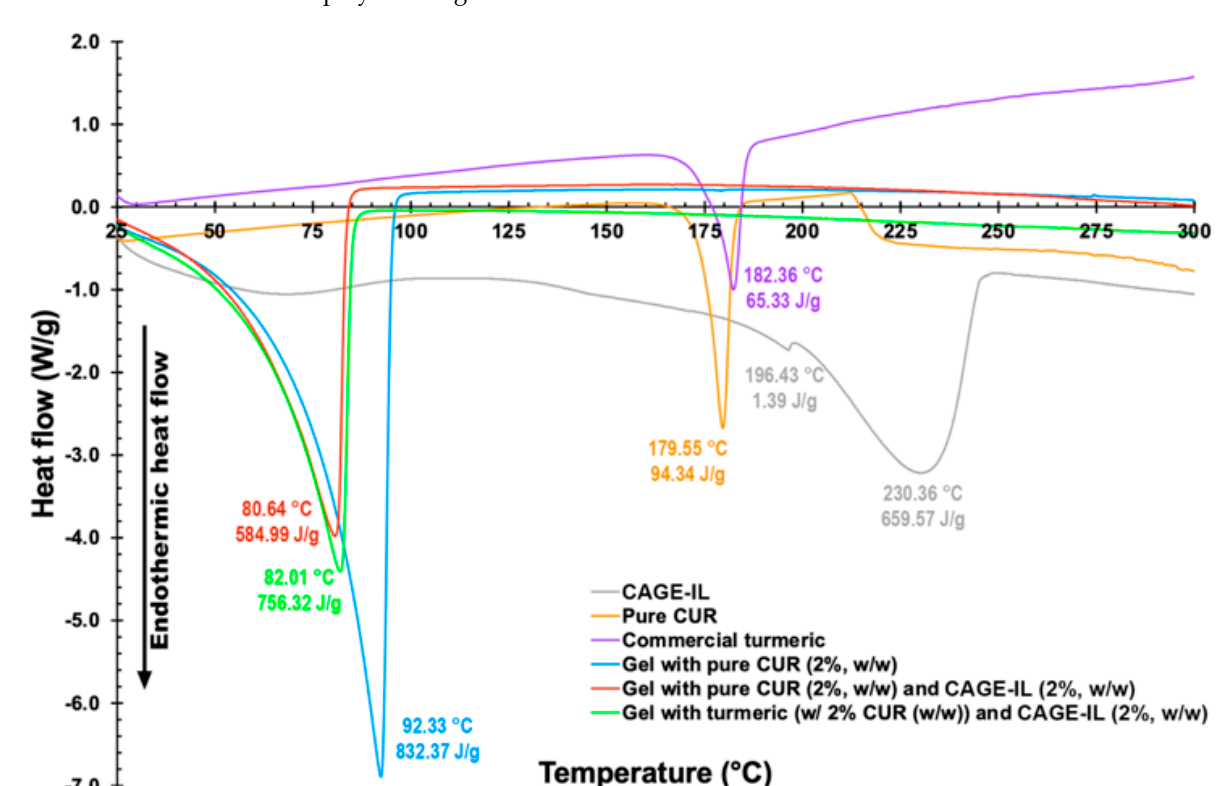
Figure 1. Differential scanning calorimetry thermograms of CAGE-IL (grey line), pure CUR (orange line), commercial turmeric (purple line), LBG gel formulation integrating pure CUR (blue line), LBG gel formulation integrating pure CUR and CAGE-IL (red line) and LBG gel formulation integrating commercial turmeric and CAGE-IL (green line).